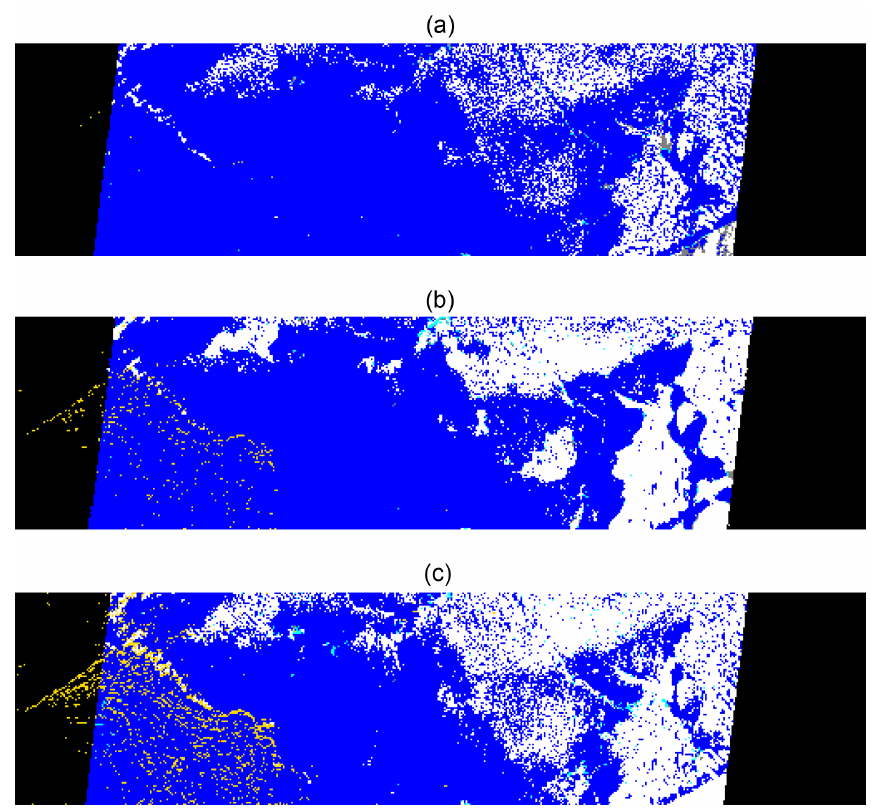
Figure 11. Maps of the MISR RCCM for Path 168, Orbit 2111, Block 110 and cameras AA (a) , BA (b) and CA (c) . Restoring the clear and cloudy areas in camera BA (b) , despite the very large number of missing values (as shown in Fig. 6), is greatly helped by the absence of missing RCCM data in the AA (a) and CA (c) cameras. Note also the increased cloud cover, as well as the more prominent impact of the local topography, when the zenith angle of observation increases. Linear dimensions are as described in the caption of Fig. 3, while color coding is identical to that indicated in Fig. 9.